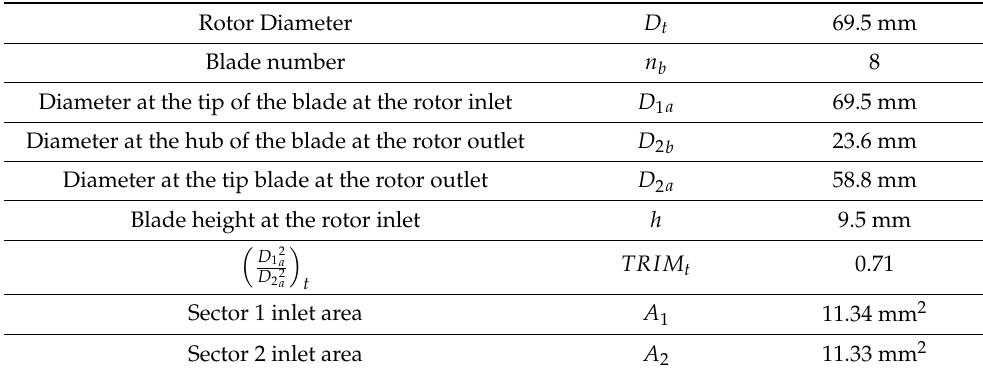
Figure 3. Tested turbocharger. Table 1. Turbine geometric characteristics.